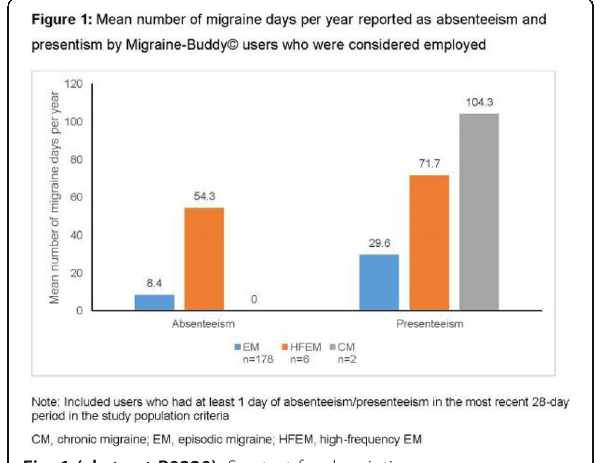
Fig. 1 (abstract P0220). See text for description